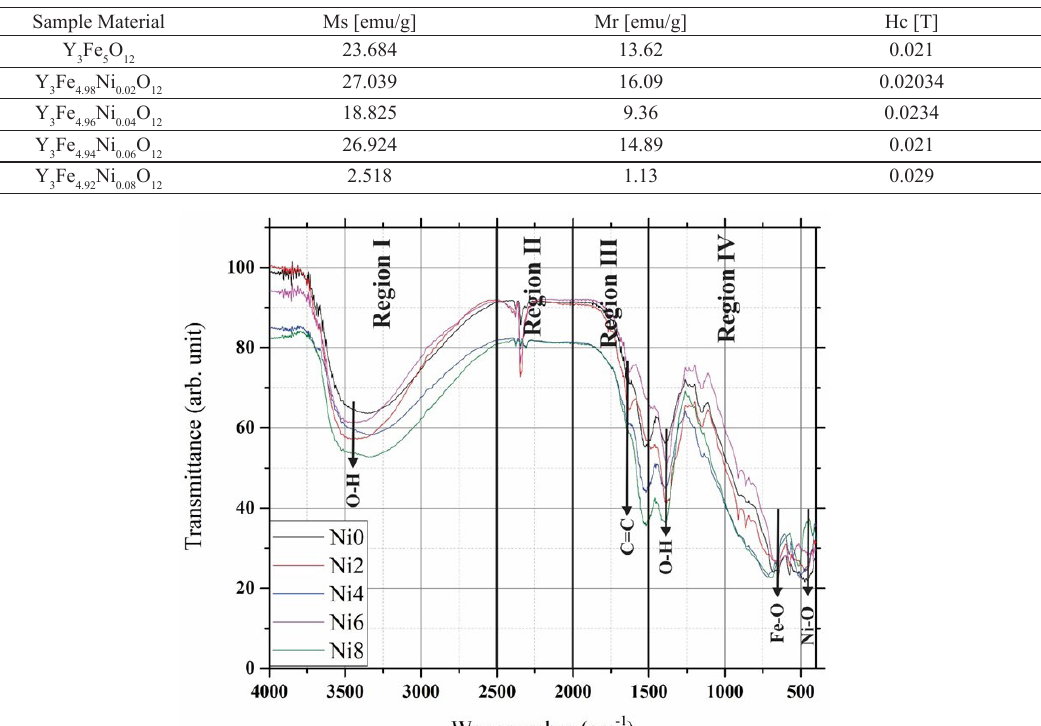
Figure 6. The hysteresis curve of Y 0.04, 0.06, and 0.08).